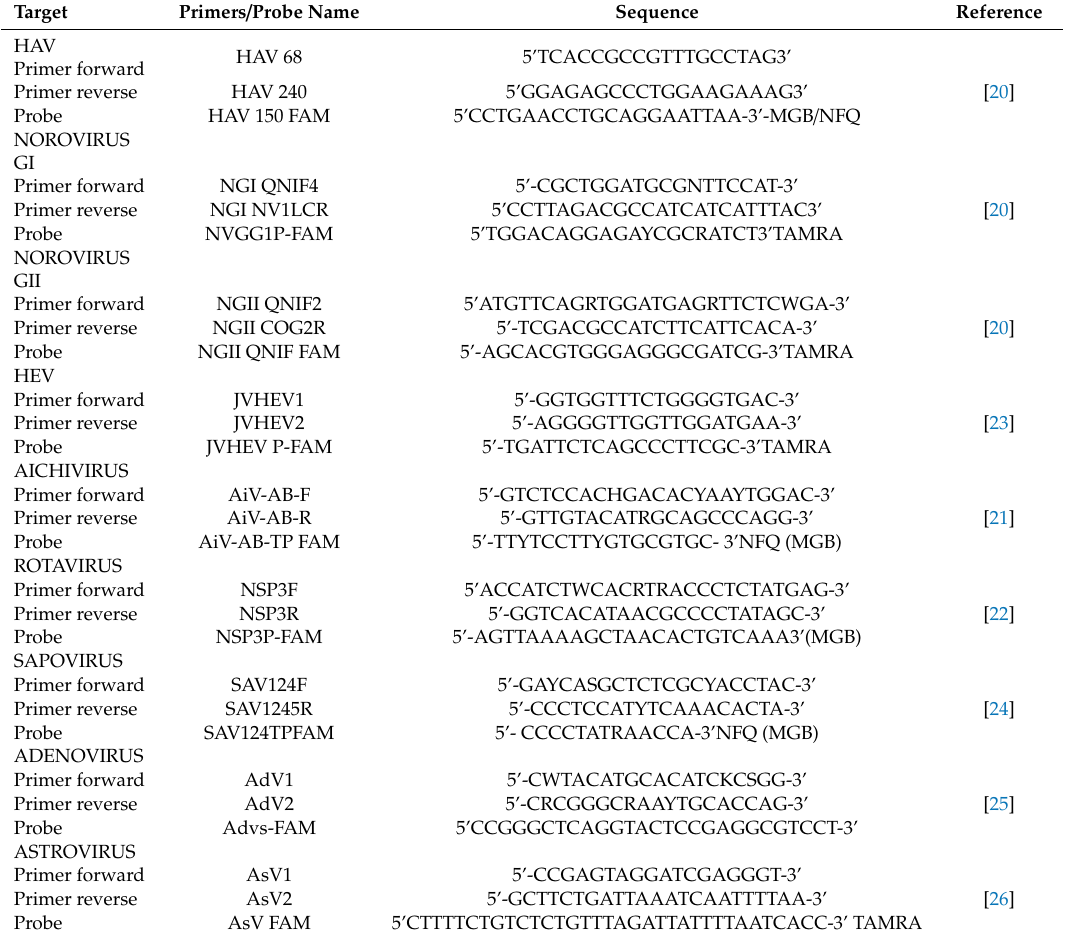
Table 3. Primers and probes for qPCR and